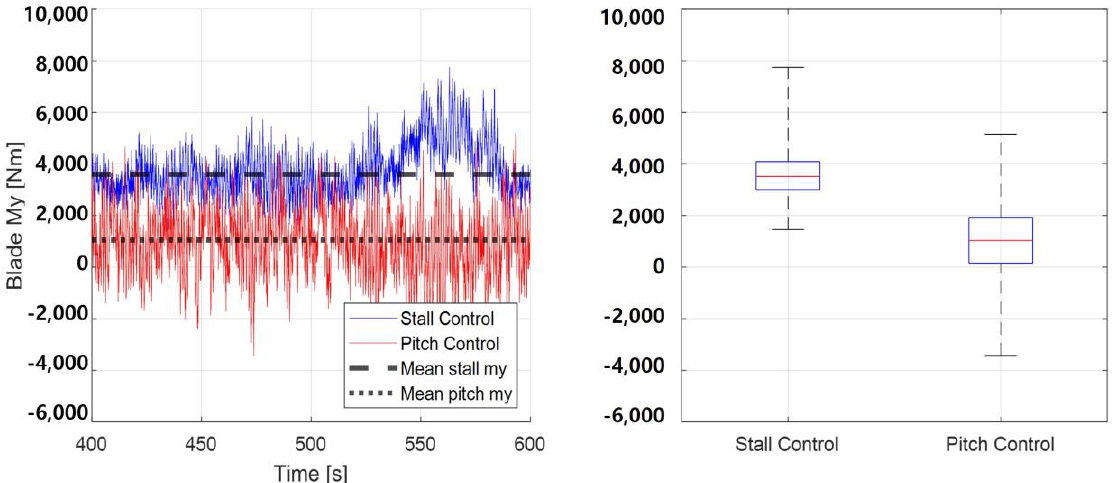
Figure 12. Load distribution of pitch control and stall control at an average wind speed of 16 m/s (mostly Region III).